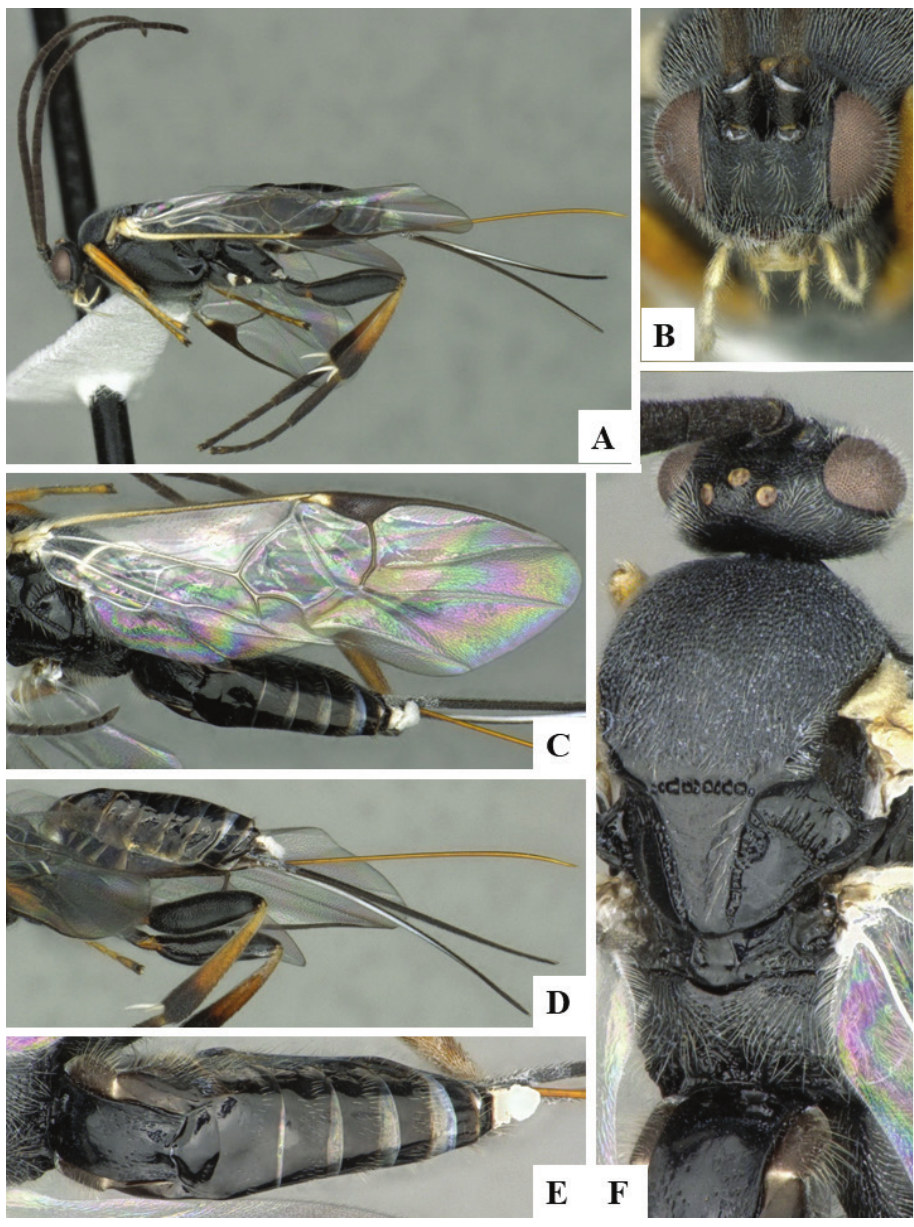
Figure 6. A–F Dolichogenidea melaniamunozae sp. n., holotype. A habitus, lateral B head, frontal; C wings D metasoma, lateral E metasoma, dorsal F head and mesosoma,